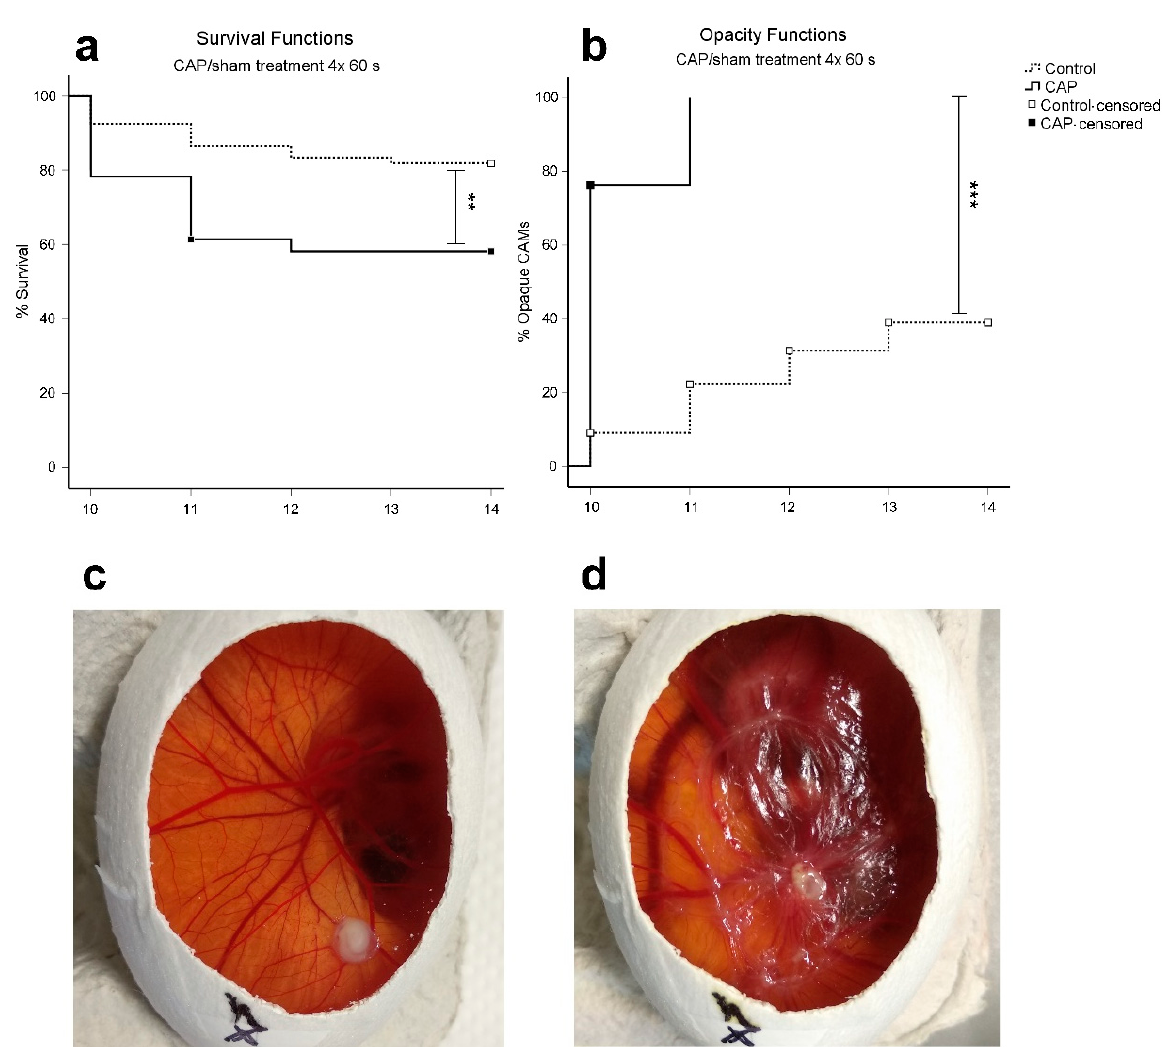
Figure 1. Kaplan–Meier curves of embryonal survival and CAM opacity after CAP treatment ( n = 101) or sham treatment ( n = 66). ( a ) The overall reduction of survival rate was highly significant ( p = 0.001) after 4 × 60 s CAP treatment compared to sham treatment; ( b ) The rate of CAM opacity occurrence was significantly higher ( p < 0.001) in CAP-treated eggs; ( c ) Representative images of an egg before CAP treatment on day 10 of incubation with clear CAM and a well-vascularized tumor ( d ) and past 4 × 60 s CAP treatment on day 14 of incubation with opaque and thickened CAM. ** p < 0.01, *** p < 0.001, in the log-rank test